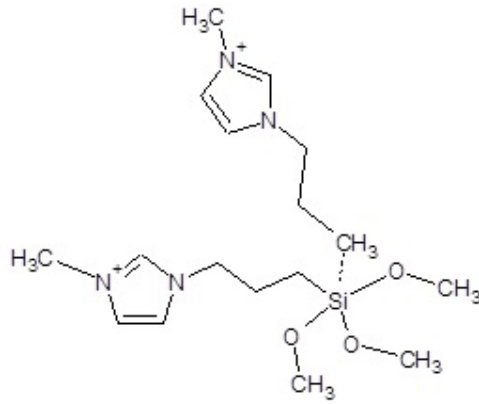
Figure 3. Proposed structure for the ionic liquid